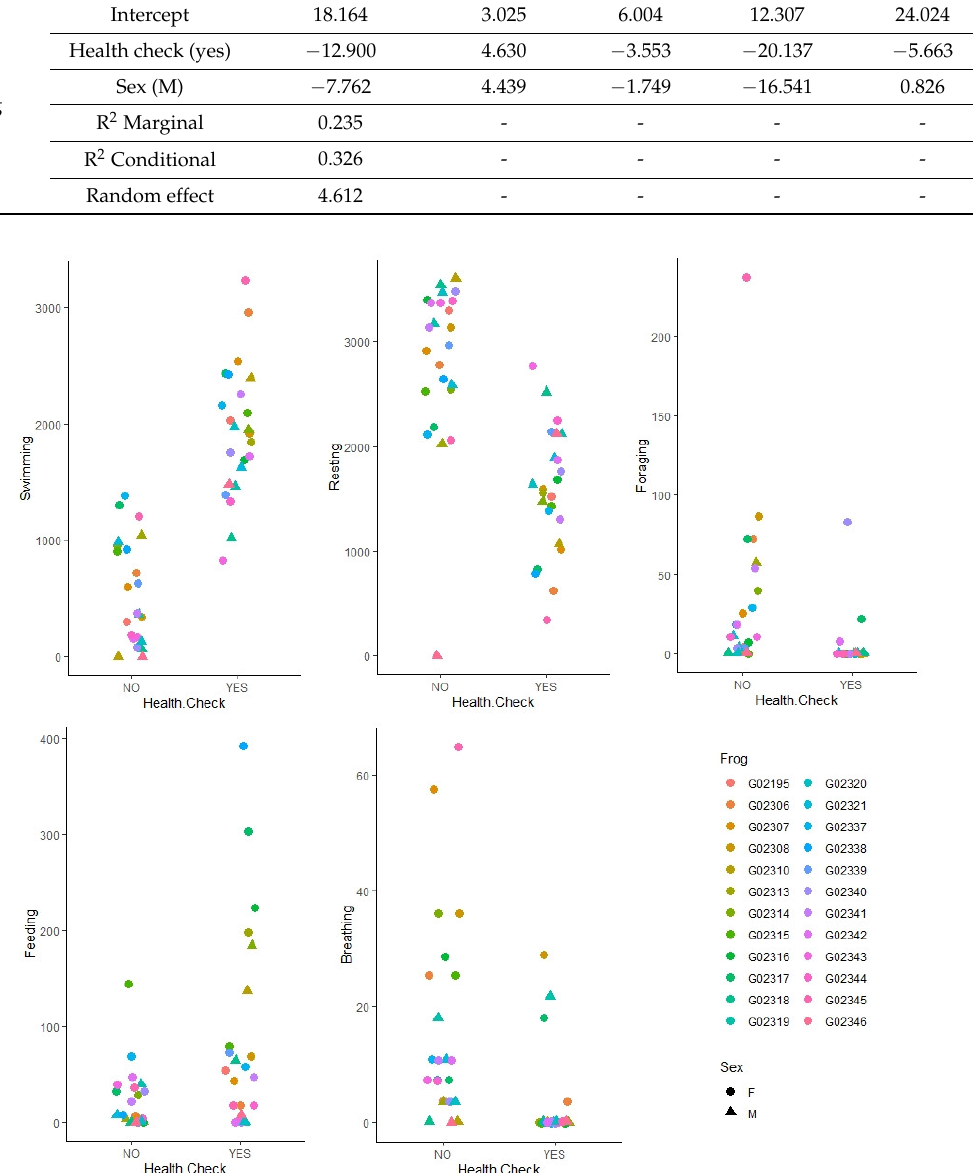
Figure 2. Mean durations of behaviors under baseline and post-health check conditions in X. longi- pes . There was a significant effect of health check on each behavior (see Table 4). Sloughing